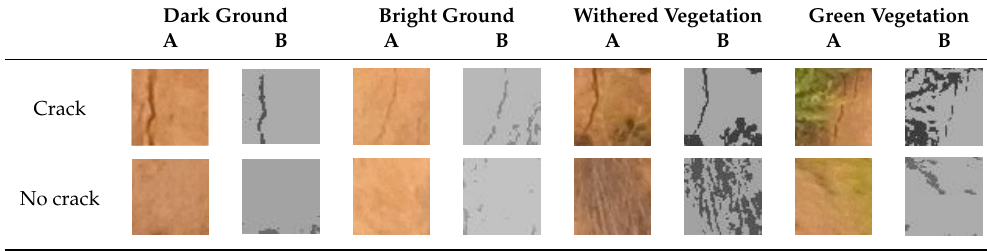
Dark Ground Dark Ground Bright Ground Table 8. Schematic diagram of the e ff ect of the image after M2GLD and original image.